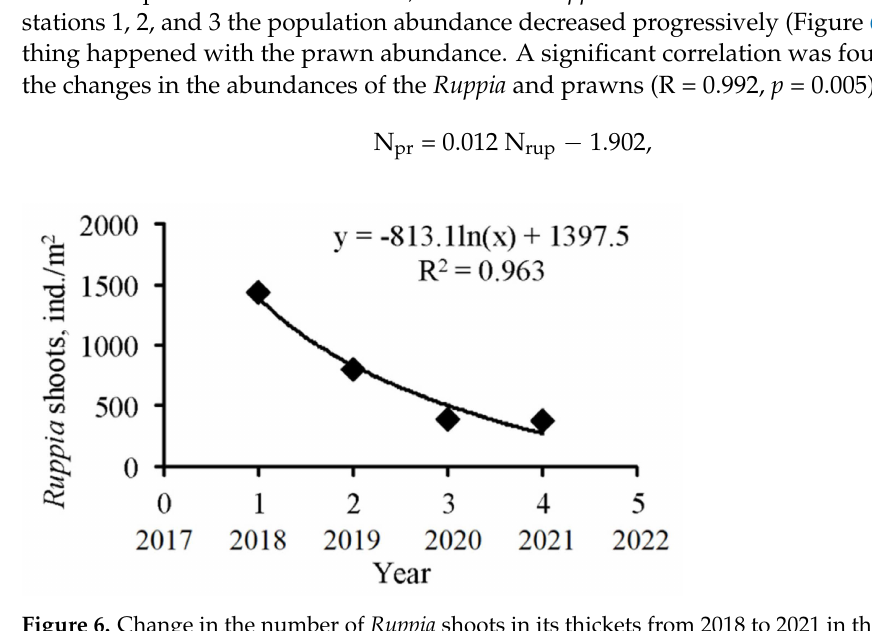
Figure 6. Change in the number of Ruppia shoots in its thickets from 2018 to 2021 in the hypersaline Lake Moynaki.